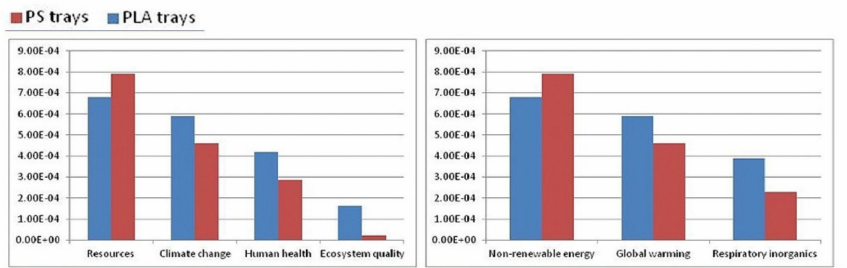
Figure 7. A comparison of the damages associated with both DCs and ICs in the life cycles of PLA and PS trays. Values are expressed as pt.kg tray − 1 . Reprinted from [16], © 2020 with permission from